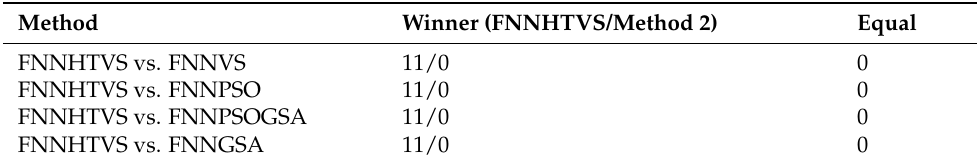
Table 8. WSR test results for the seed classification problem.